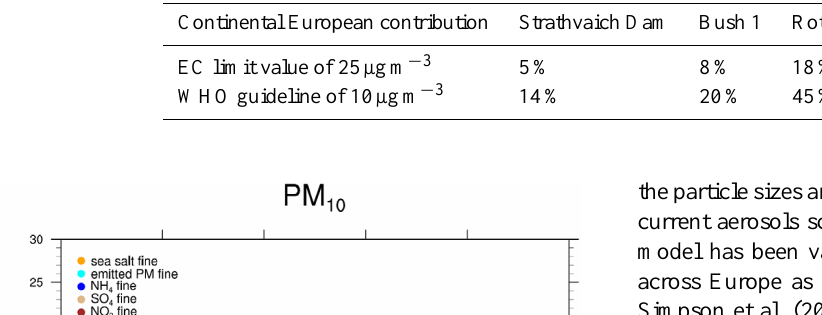
Table 2. Model simulated contributions of Continental European PM 2 . 5 import to the current European Commission limit value (EC, 2013) and to the World Health Organization guideline value (WHO, 2005) at each of the four sites for the EMEP4UK model simulations for the year 2003.